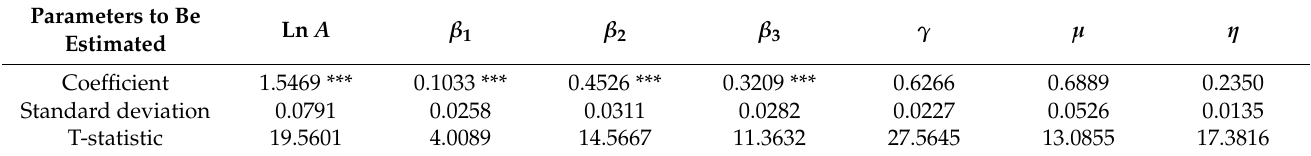
Table 1. Stochastic frontier production function model’s estimated